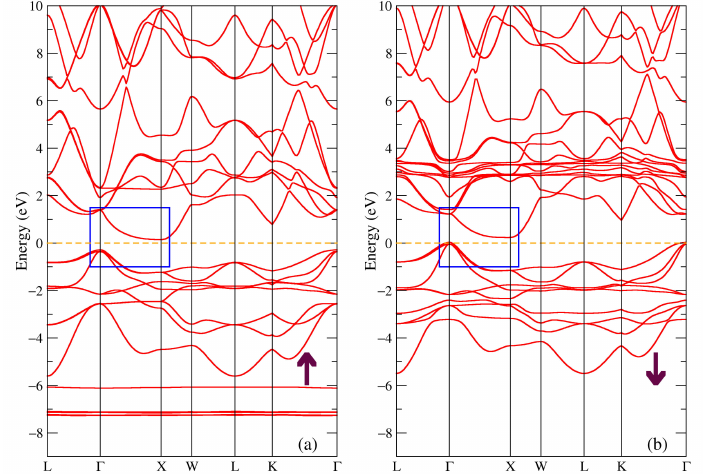
Figure 3. Band structure of TbNiSb: ( a ) majority and ( b ) minority spin projections. The blue rectangle points out the bands involved in the band gap formation.